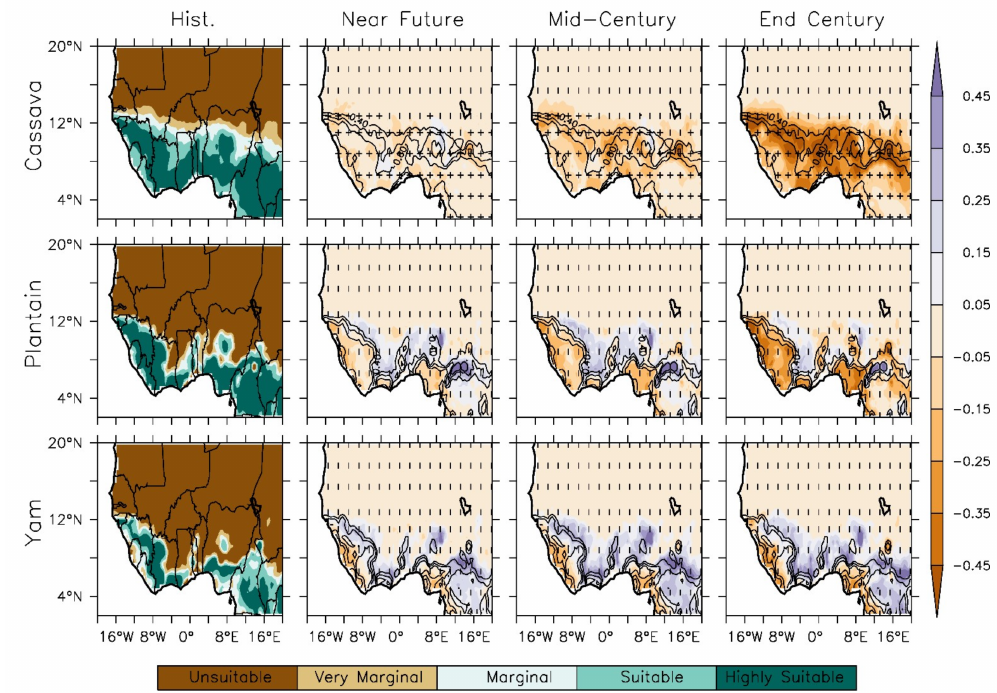
Figure 5. Same as Figure 3 but for the root and tuber crops, cassava, plantain and yam. Along the coastal areas, legumes and root and tuber crops are suitable along the south-west coast of Senegal to the south-west coast of Cameroon. High SIV are observed for the root and tuber crops, plantain and Yam in the north central part of Nigeria in the Savanna. It is worth mentioning because the surrounding areas are observed to be unsuitable for the cultivation of both crops. For cereals, pearl millet is suitable along the west coast of Senegal and from the south coast Ivory Coast to the south-west coast of Cameroon. Maize is suitable from the south coast of Ivory Coast to the south-west coast of Nigeria. Fruit and horticultural crops are all suitable along the south coast of the Ivory Coast to the south-west coast of Nigeria. Mango and pineapple are suitable along the west coast of Senegal to Gambia while orange and tomato are only suitable along the west coast of